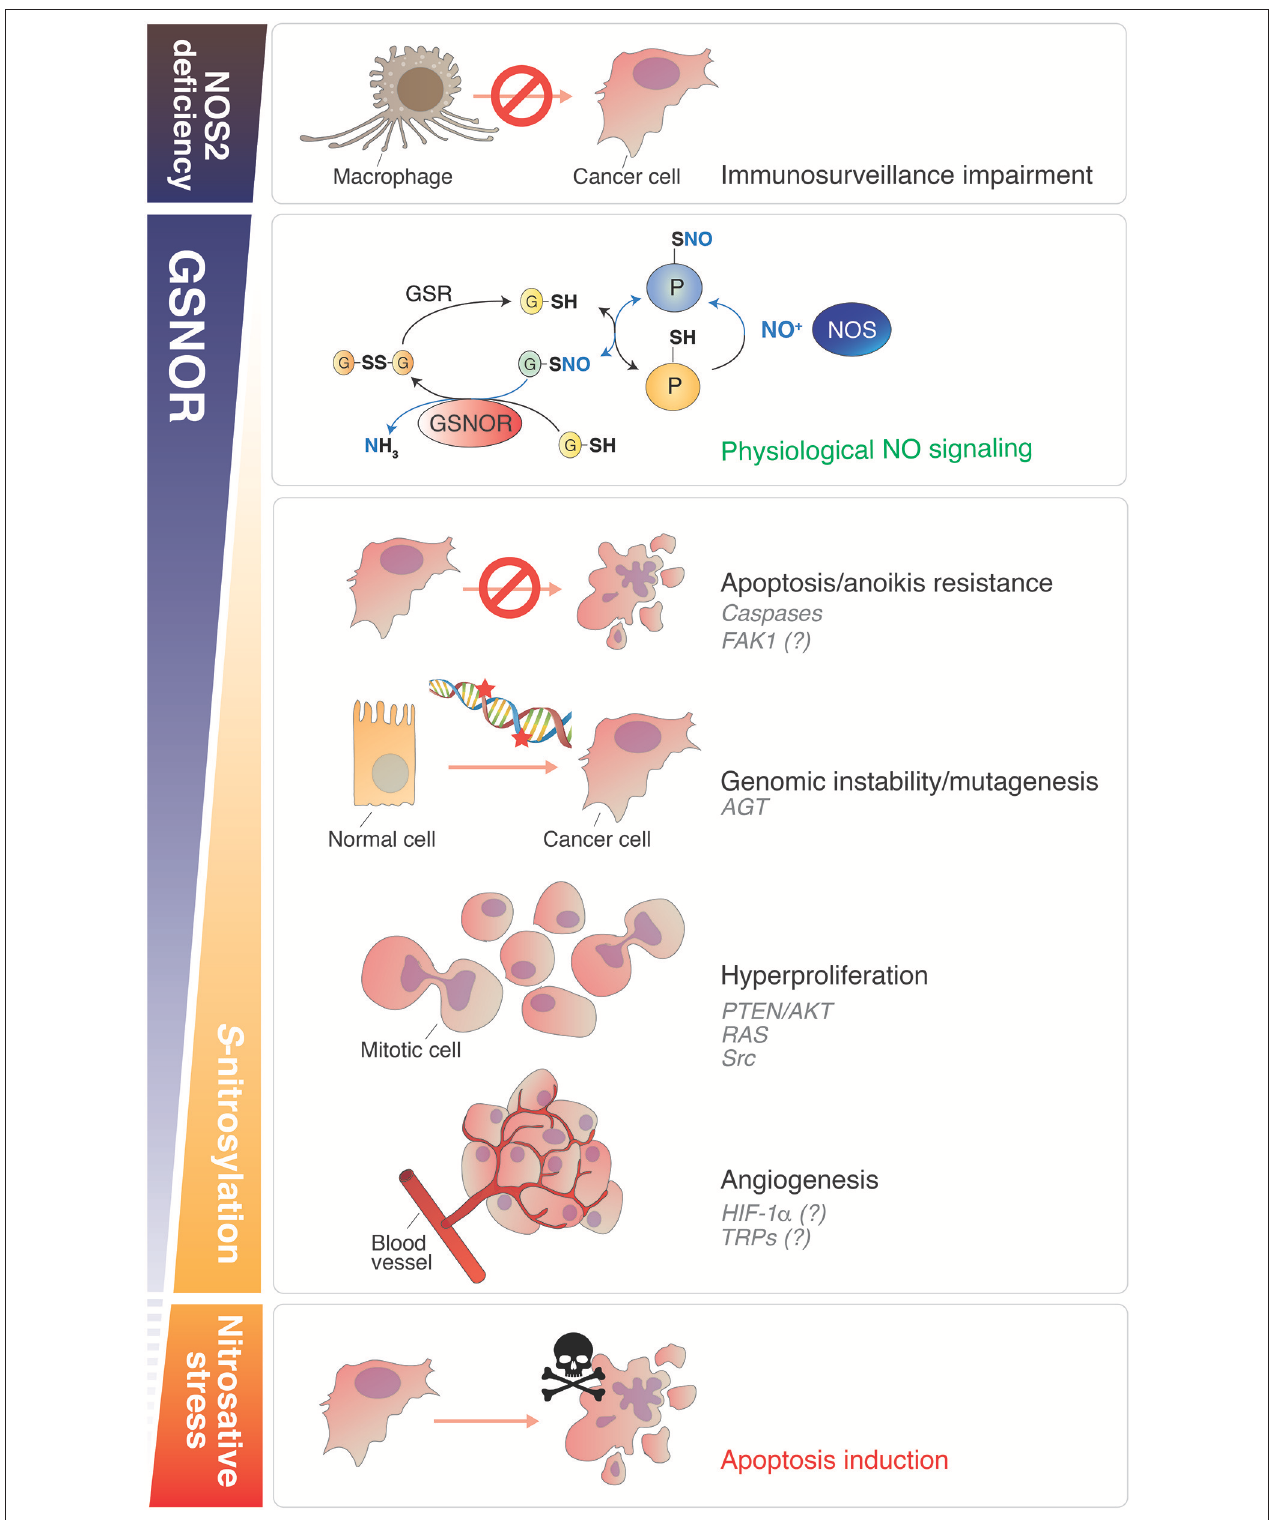
FIGURE 1 | Roles of NO signaling and protein denitrosylation in cancer. Nitric oxide plays different roles in cancer biology depending on its concentration. GSNOR is the main cellular denitrosylase. Counteracting the effects induced by NOS, GSNOR finely modulates protein S -nitrosylation (second panel from the top), which is establishing as the main posttranslational modification underlying NO bioactivity. A disbalance in NO signaling can promote tumor induction, survival and progression.